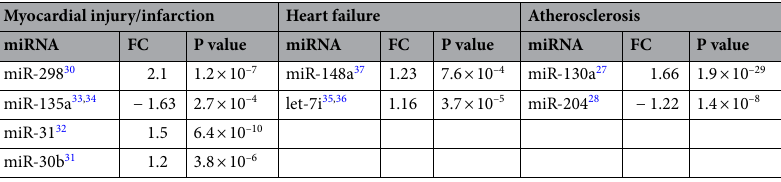
Table 2. CVD-related candidate miRNAs in murine heart tissue. FC and P values for differentially expressed miRNAs between wild-type and AGAT knock-out mice in heart tissue are shown. MiRNAs were selected based on known association with CVD and grouped according to the most prominent association with a specific CVD or risk factor. Relevant references are provided for each miRNA. FC: fold change.